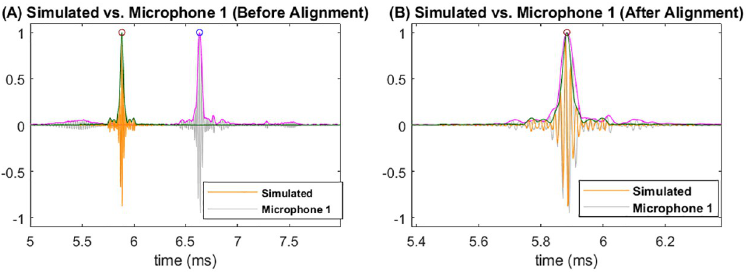
Fig 2. Align simulated and measured impulse responses by matching the highest peak of the envelopes. (A) Before alignment. (B) After